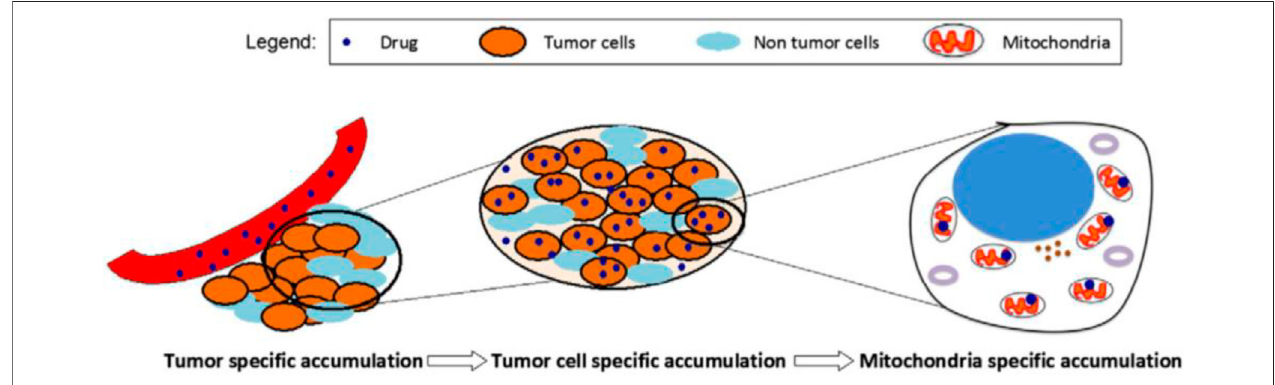
FIGURE 2 | A schematic representing the mitochondria-speci fi c targeting strategy (D ’ Souza et al.,